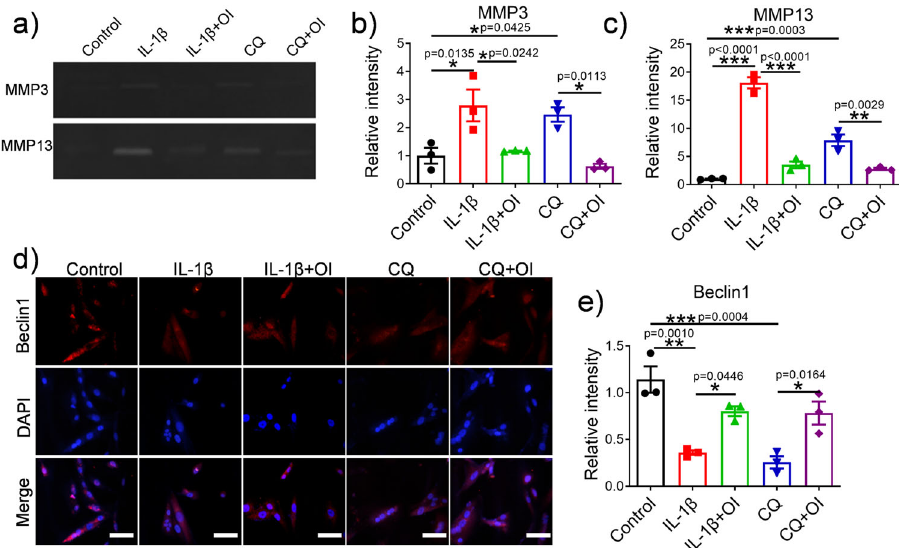
Fig. 5 Effects of OI on the expression of cartilage degradation-related proteins and autophagy markers. a – c Zymographic analysis of the effects of IL-1 β , CQ and OI on the enzymatic activities of MMP3 and MMP13 and the quanti fi cation of MMP3 and MMP13 expression ( n = 3). d , e Representative immuno fl uorescence photomicrograph of Beclin1 (red)-labelled chondrocytes and the fl uorescence intensity quanti fi cation of Beclin1 expression ( n = 3) (scale bar = 50 μ m). Nuclei were stained with DAPI (blue). The error bar is SD. The data are expressed by mean ± SD. * P < 0.05, ** P < 0.01, *** P <